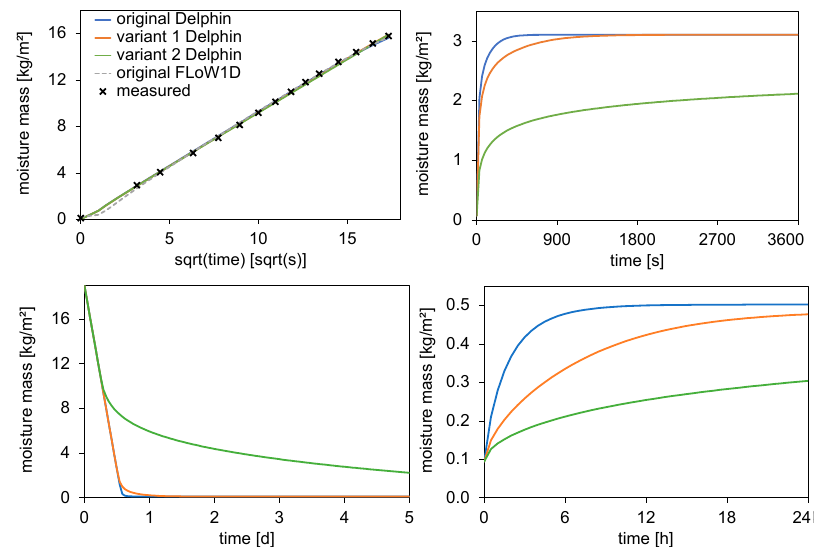
Figure 4. ( top left ) Delphin simulations of capillary absorption for the original OPS limestone and two variants, complemented with original measurements and FLoW1D calculation (blue and orange lines are hidden underneath the green line); ( top right ) Delphin simulations of moisture redistribu- tion; ( bottom left ) Delphin simulations of isothermal drying; ( bottom right ) Delphin simulations of hygroscopic adsorption.